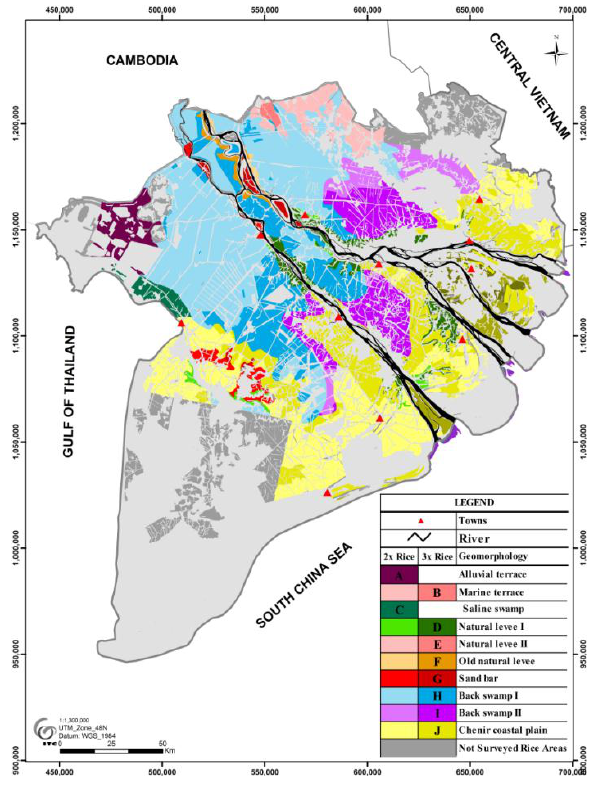
Figure 6. The Landscape-ecological map.